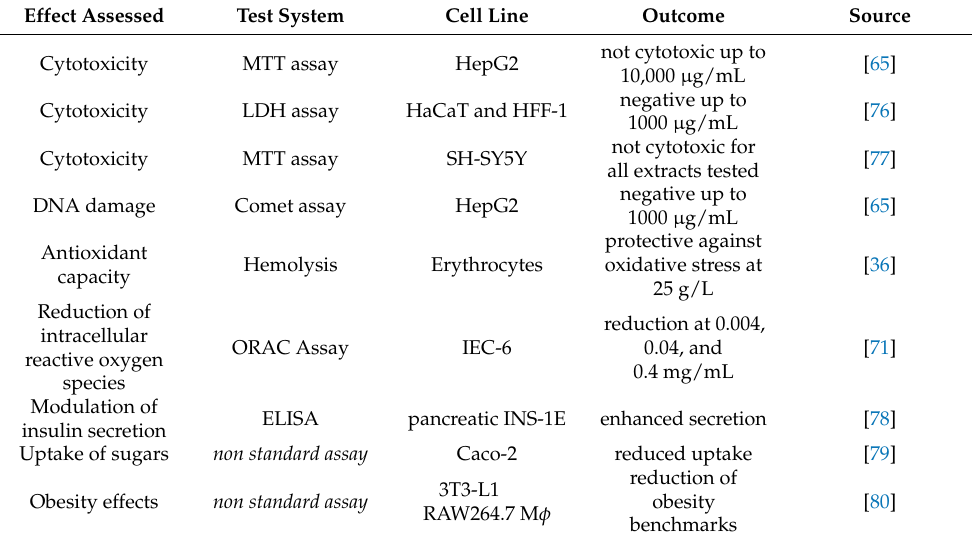
Table 6. Summary of studies of roasted coffee silver skin in various cell